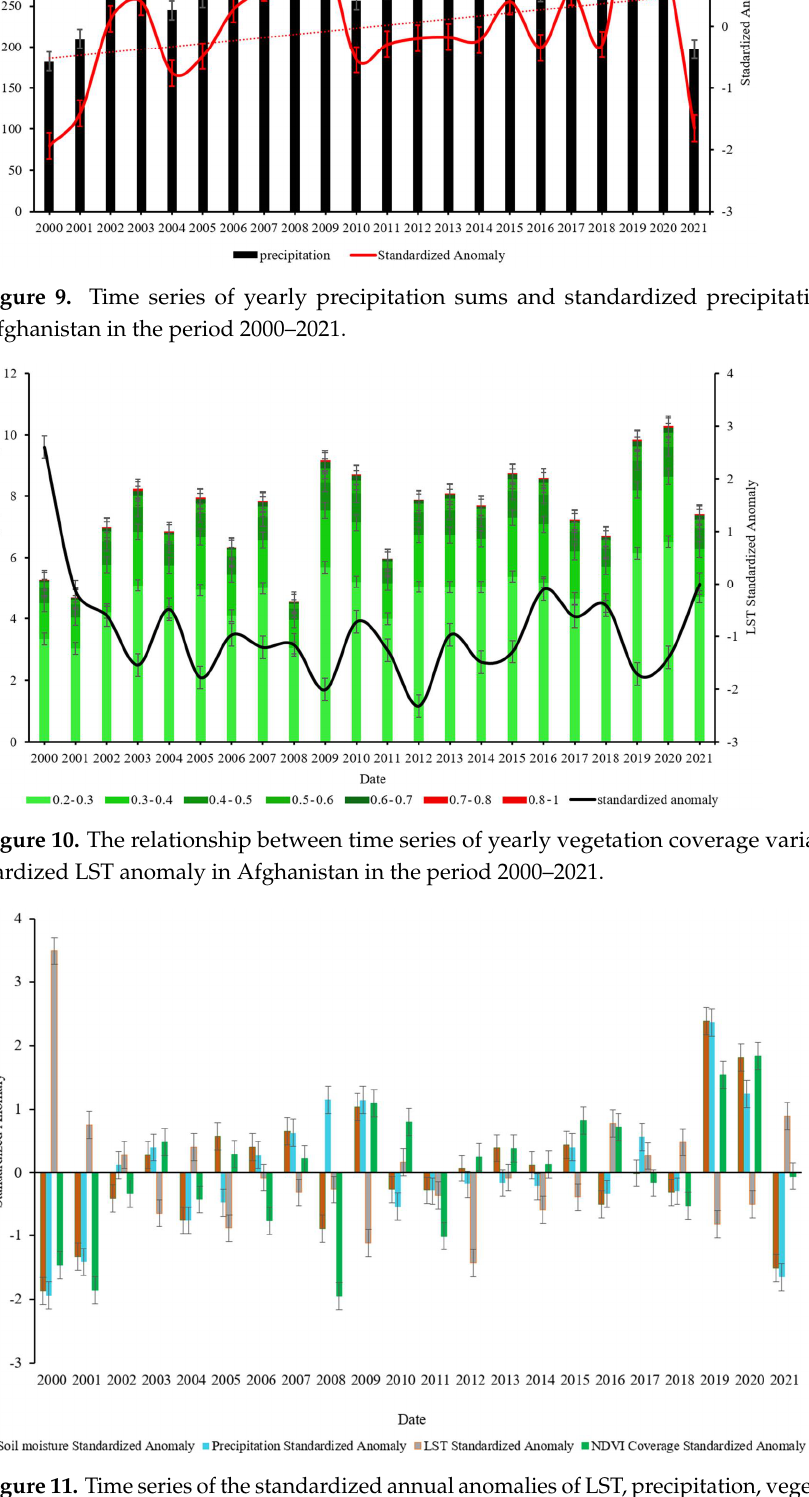
Figure 11. Time series of the standardized annual anomalies of LST, precipitation, vegetation cov- erage, and soil moisture in Afghanistan in the period 2000–2021.